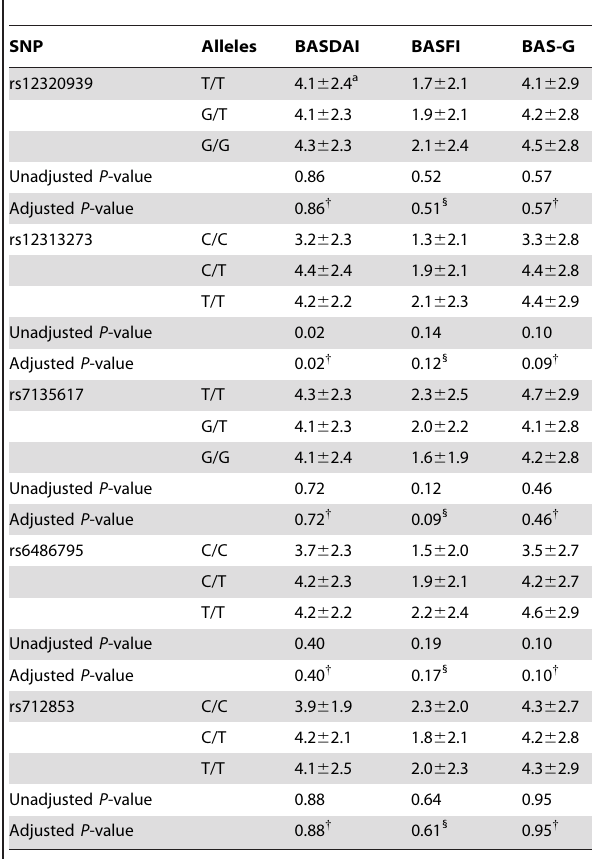
Table 3. Difference in the scores of BASDAI, BASFI, and BAS-G among AS patients stratified by different ORAI1 alleles.